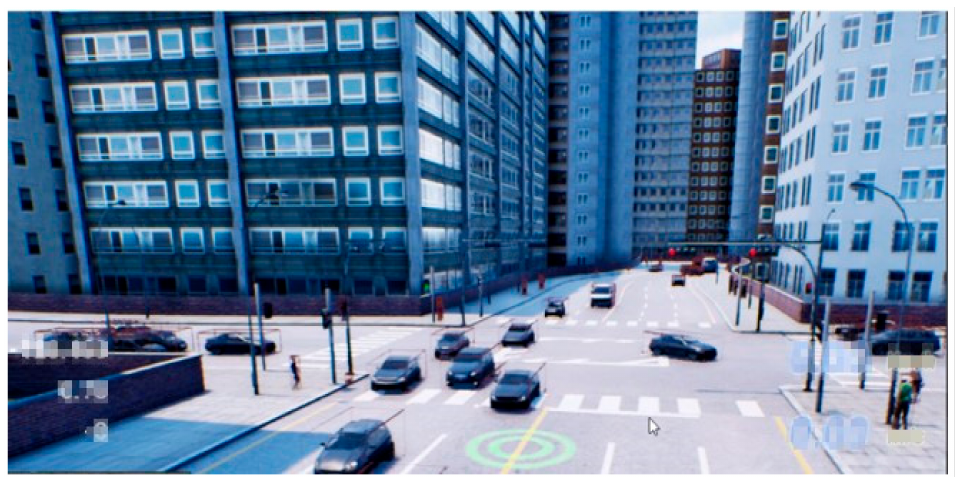
Figure 11. City scenario result of normal mode.